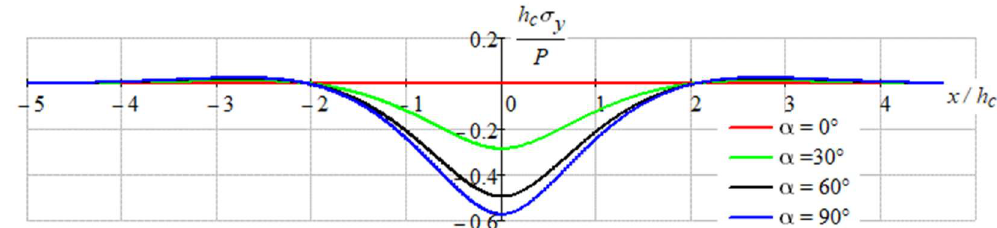
Figure 9. Distribution of normal stresses x  in the coating at the boundary of contacts between the layers ( 2/ с hy  ).